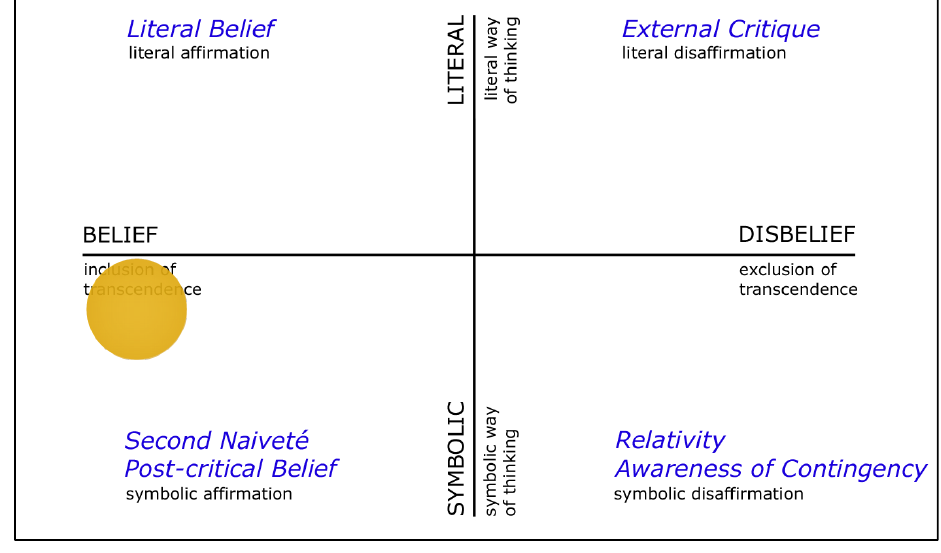
Figure 1. Framework of the Post-Critical Belief Scale with 'golden dot'.